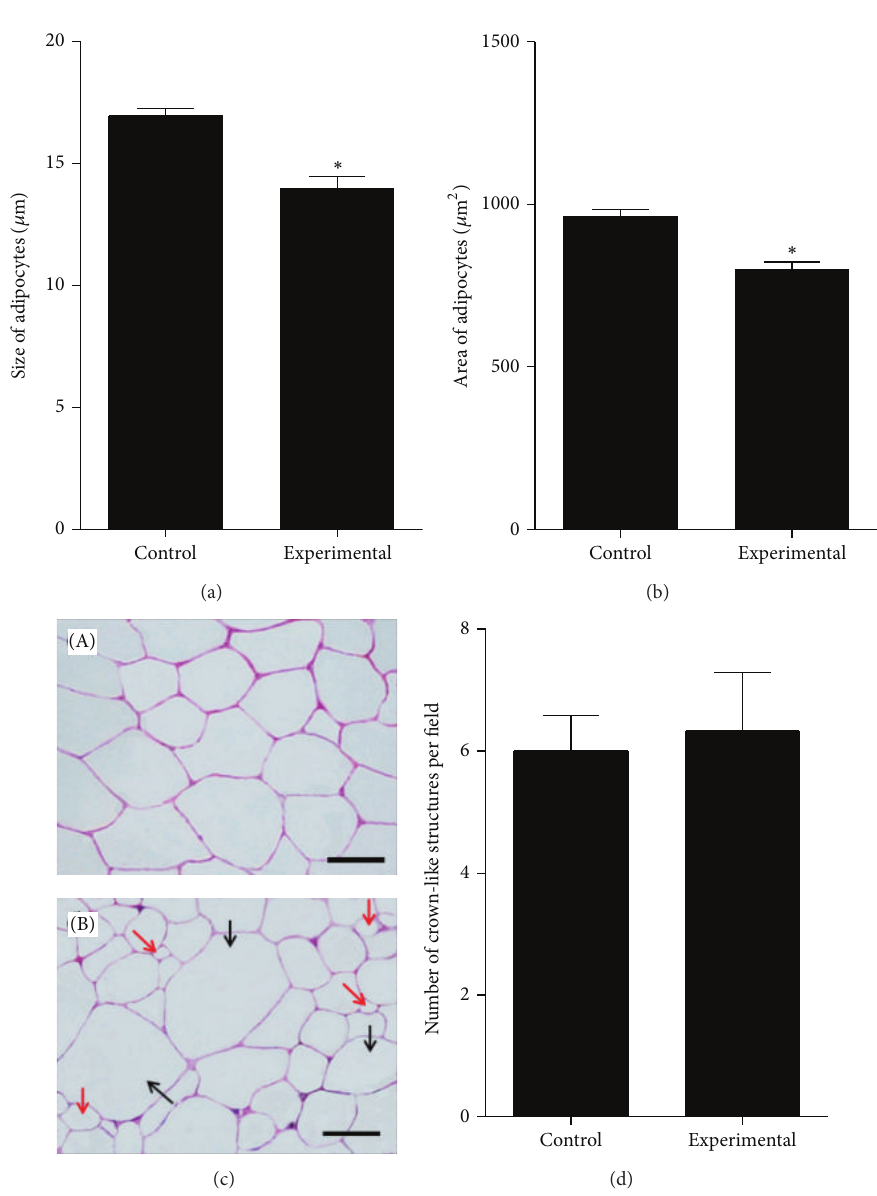
Figure 10: The results of morphometric analyses: comparison of the adipocytes size (a) and areas (b) in tissue of control and experimental group. Differences in cells dimensions were statistically significant at 𝑃 < 0.05 ( ∗ ). Morphometric analysis of adipocytes was performed on six sections separately. Calculations were expressed as a mean value ( 𝑌 -axis). (c) The results of hematoxylin-eosin (H-E) staining of adipose tissue sections derived from control group (A) and experimental group (B). Diversity of adipocytes in tissue of mice treated with metformin was indicated with arrows: red is indicating cells smaller in size and black is indicating cells of larger size. Scale bar is 75 𝜇 m. (d) The results of crown-like structures determination performed on six different microscopic images. Crown-like structures are visible in sections as aggregated macrophages accumulated and fused around